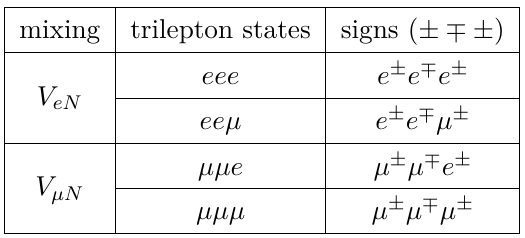
Figure 2 . Cross sections of trilepton signal process with m N = 100 GeV to 1 TeV at (left), 27 TeV (middle) and 100 TeV (right), with ‘ = µ . Exclusive cross sections for the processes with 0 jet (red), 1 jet (green) and 2 jets (blue) are shown for comparison. The acceptance cuts in table 1 have been applied.